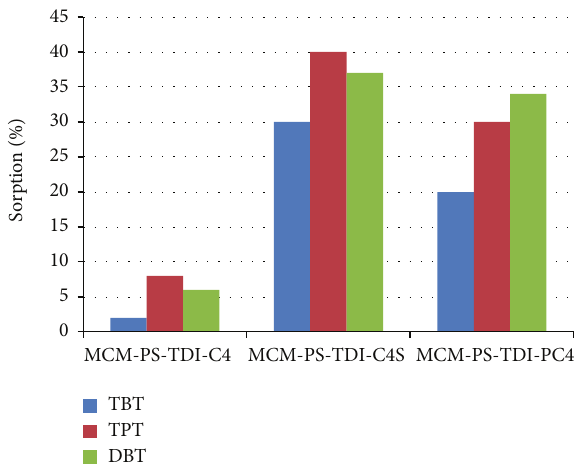
Figure 7: Sorption percentages of organotins compounds by MCM- PS-TDI-calix [4] arene derivatives